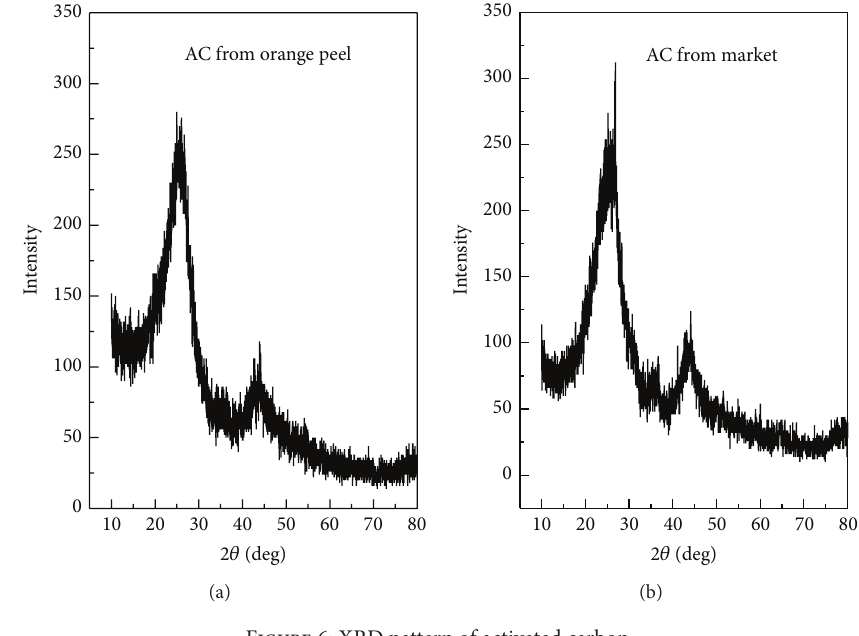
Figure 6: XRD pattern of activated carbon.